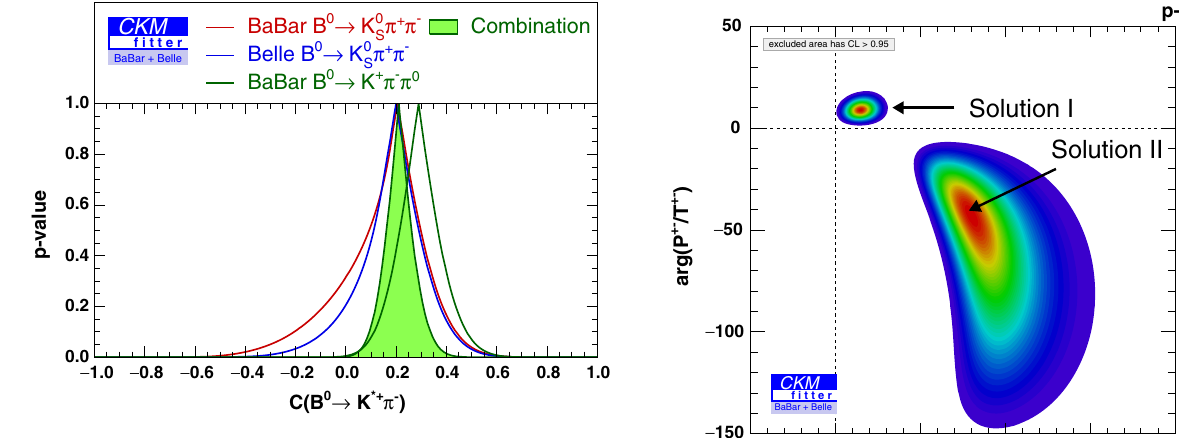
Fig. 3 Constraint on the direct CP asymmetry parameter C ( B 0 → K (cid:7) + π − ) = − A CP ( B 0 → K (cid:7) + π − ) from BaBar data on B 0 → π + π − ( red curve ), Belle data on B 0 → K 0 π + π − ( blue curve ), K 0 S S BaBar data on B 0 → K + π − π 0 ( green curve ) and the combination Fig. 4 Two-dimensional constraint on the modulus and phase of the of all these measurements (green shaded curve ). The constraints are P +− / T +− ratio. For convenience, the modulus is multiplied by the obtained using the observables described in the text ratio of CKM factors appearing in the tree and penguin contributions to the B 0 → K (cid:7) + π − decay amplitude uses isobar values as inputs which are averaged over the var- a global feature of our non-linear fit, arising from the over- all structure of the current combined measurements (central values and uncertainties) that we use as